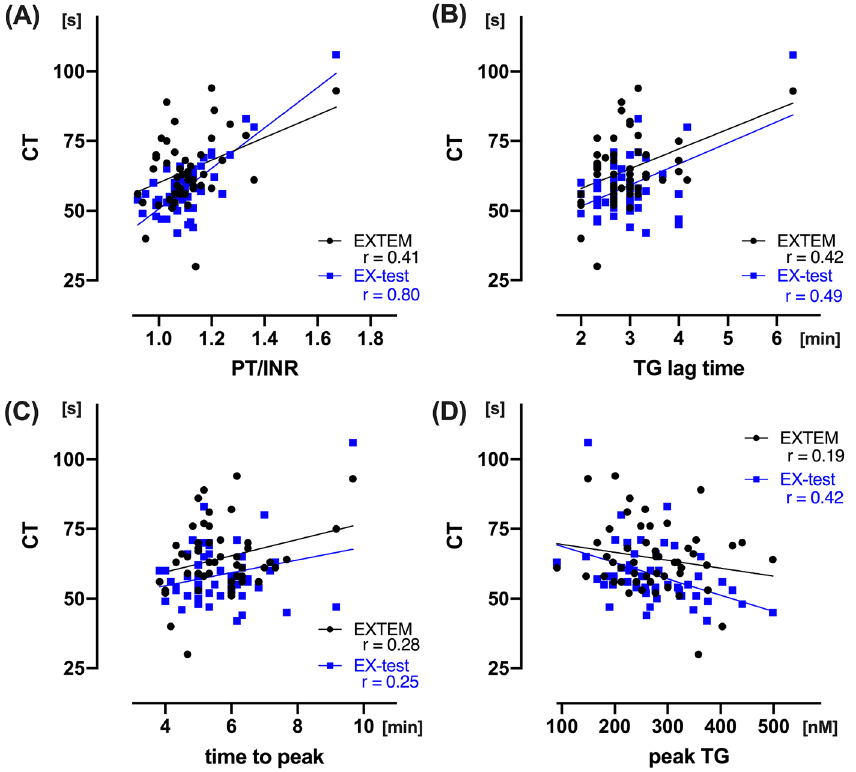
Figure 2. Correlation between EX-test/EXTEM CT and laboratory coagulation variables. Linear regression analysis, between EX-test/EXTEM CT and PT/INR ( A ), TG lag time ( B ), TG time to peak ( C ), and peak TG ( D ). CT clotting time, PT/INR prothrombin time/international normalized ratio, TG thrombin